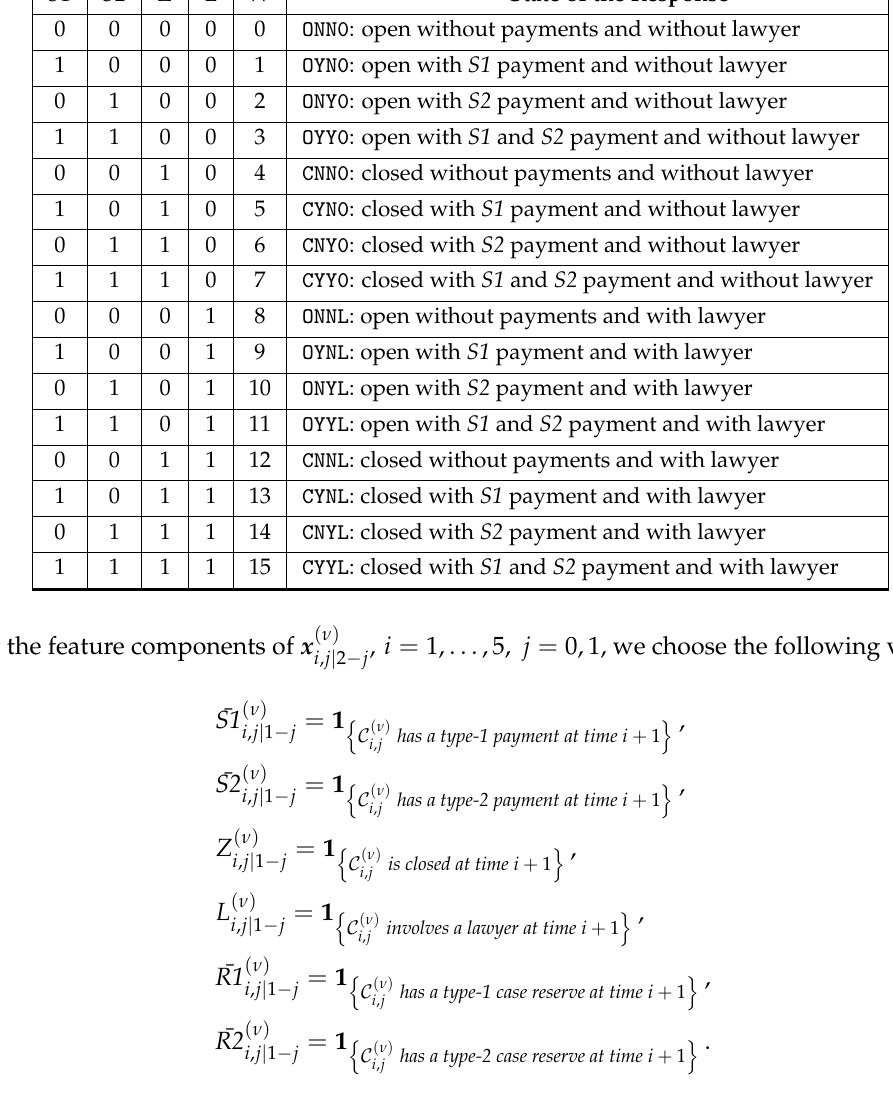
Table 5. Structure of the response variables W